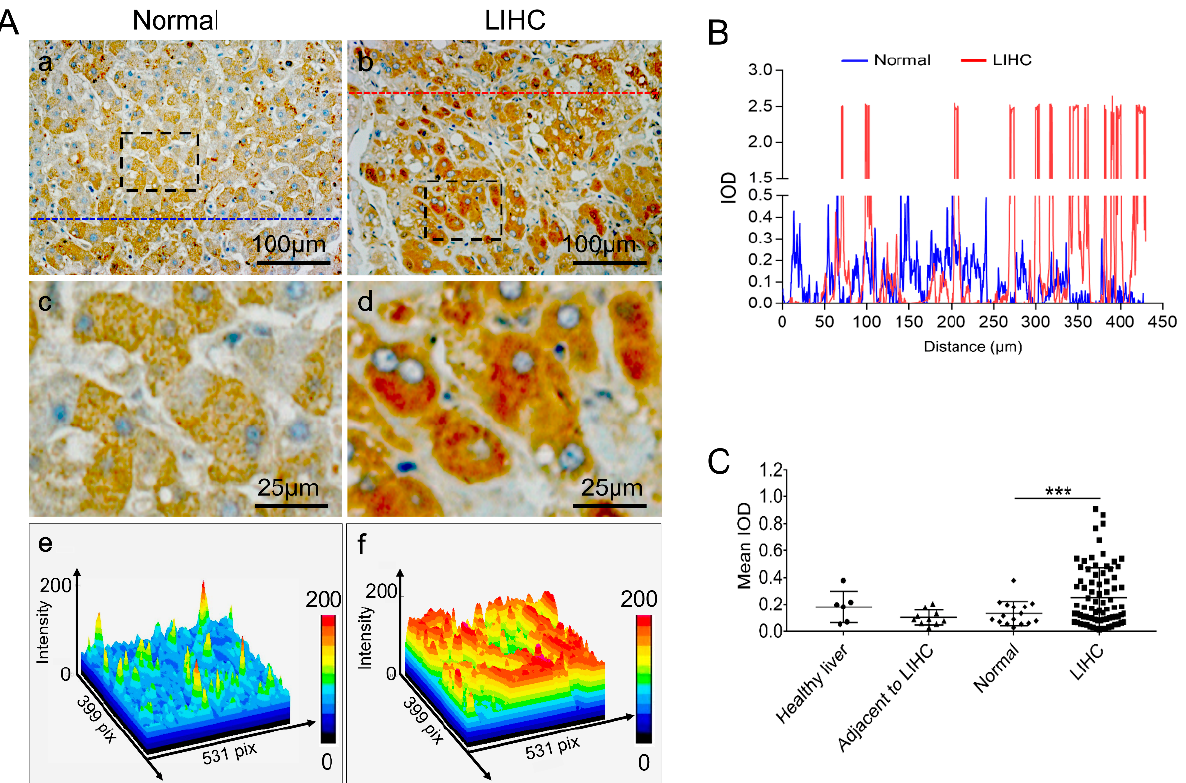
Figure 3. Human tissue microarray including hepatocellular carcinoma and normal liver tissue analysis revealed that the expression of FKBP1A was significantly elevated in LIHC patients. ( A ) Rep- resentative IHC images of FKBP1A in normal liver ( a ) or LIHC patients ( b ). ( c ) Shows the enlarged image of the black box in ( a ); ( d ) is the enlarged image of the black box in ( b ). The density distribution of ( c , d ) are shown in panels ( e , f ). n (normal) = 16; n (LIHC) = 79. ( B ) The plot profiles of the intensity of FKBP1A protein in hepatocytes of normal tissues and LIHC along the straight line (as shown ( a) and ( b ). ( C ) Quantification of the mean optical density (mean IOD) of FKBP1A protein by IHC staining in healthy liver, adjacent to LIHC or LIHC tissues. The normal group includes healthy liver and adjacent to LIHC tissues. n (healthy liver) = 6; n (adjacent to LIHC) = 10; n (normal) = 16; n (LIHC) = 79. Data are presented as the means ± SD. *** p < 0.001.